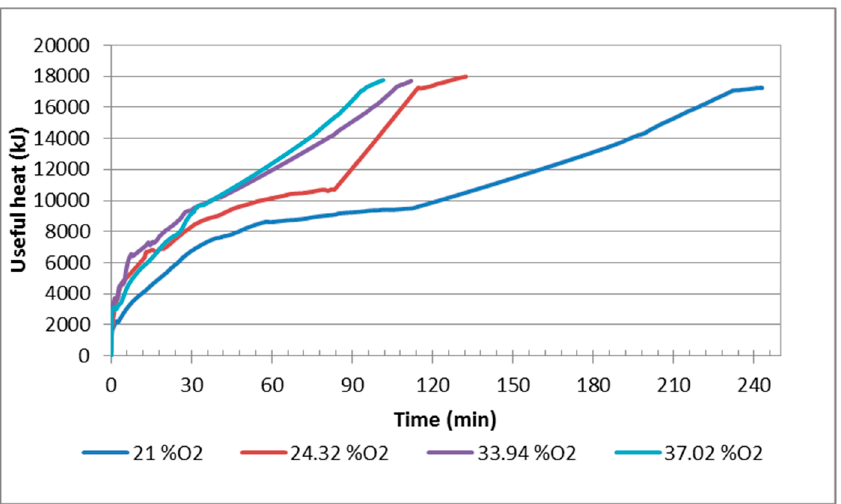
Figure 11. The increase in the specific heat of the charge during the aluminium ingot melting process related to the change of the oxidizer oxygen concentration using an optimised air nozzle.